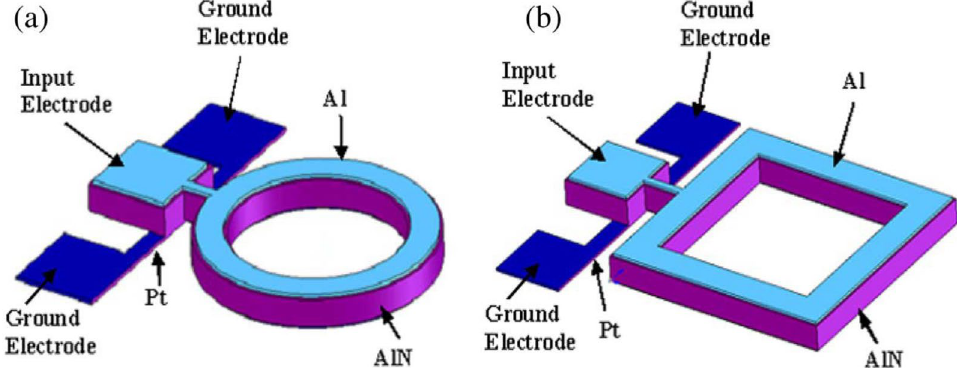
Fig. 5 Micromechanical AlN ring-shaped contour-mode resonators: ( a ) One port circular ring and ( b ) One-port square-shaped ring